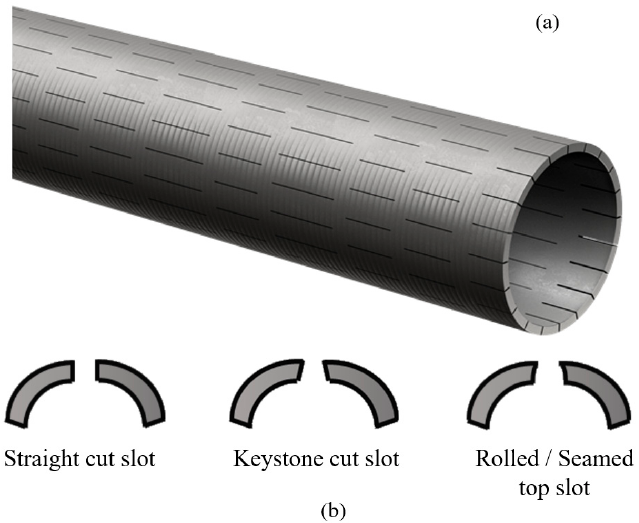
Figure 2. ( a ) The slotted liner schematics [26] and ( b ) schematic of the slot geometries (modified from Bennion et al. [17]).